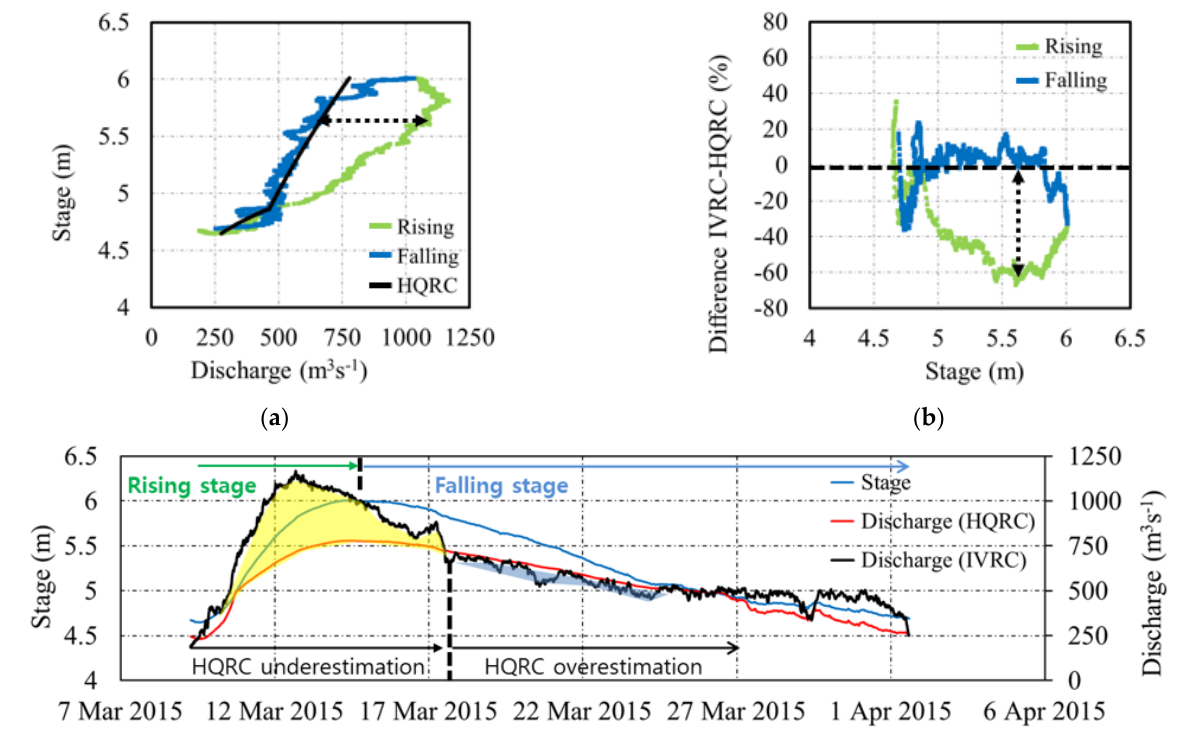
Figure 10. Inferences from the IVRC-HQRC comparison: ( a ) stage vs. discharge relationships; ( b ) numerical values for the differences in Figure 10a; and ( c ) time series for IVRC and HQRC methods.